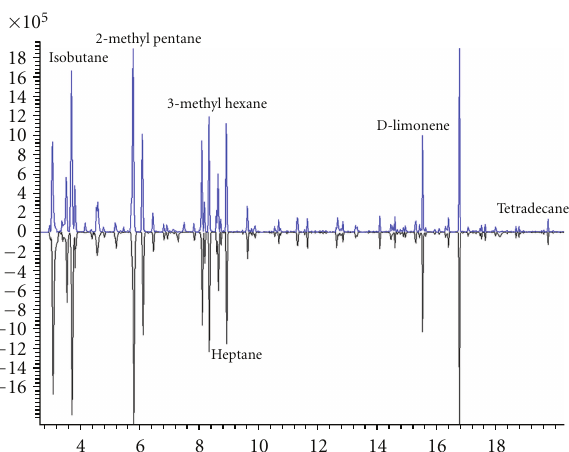
FIGURE 9: Comparison of results from two identical 1 L laboratory air samples, one collected using a constant-flow pump (black) and the other collected using piston pump (blue), analysed by TD–GC/MS (TD- 100, Markes International Ltd), method conditions shown in Table 8.